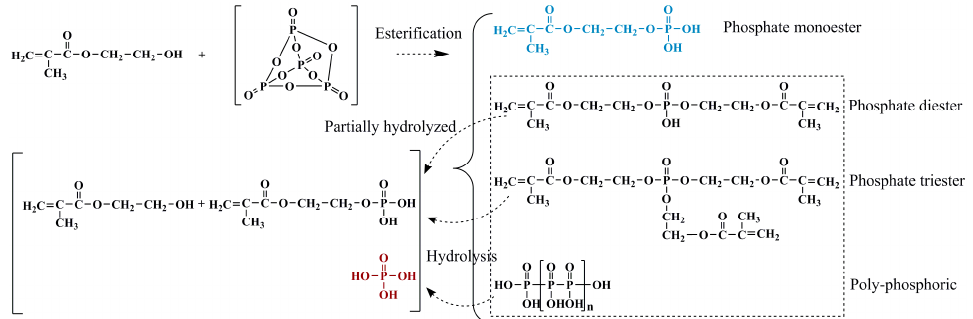
Figure 1. Synthesis route of HPN monomer.